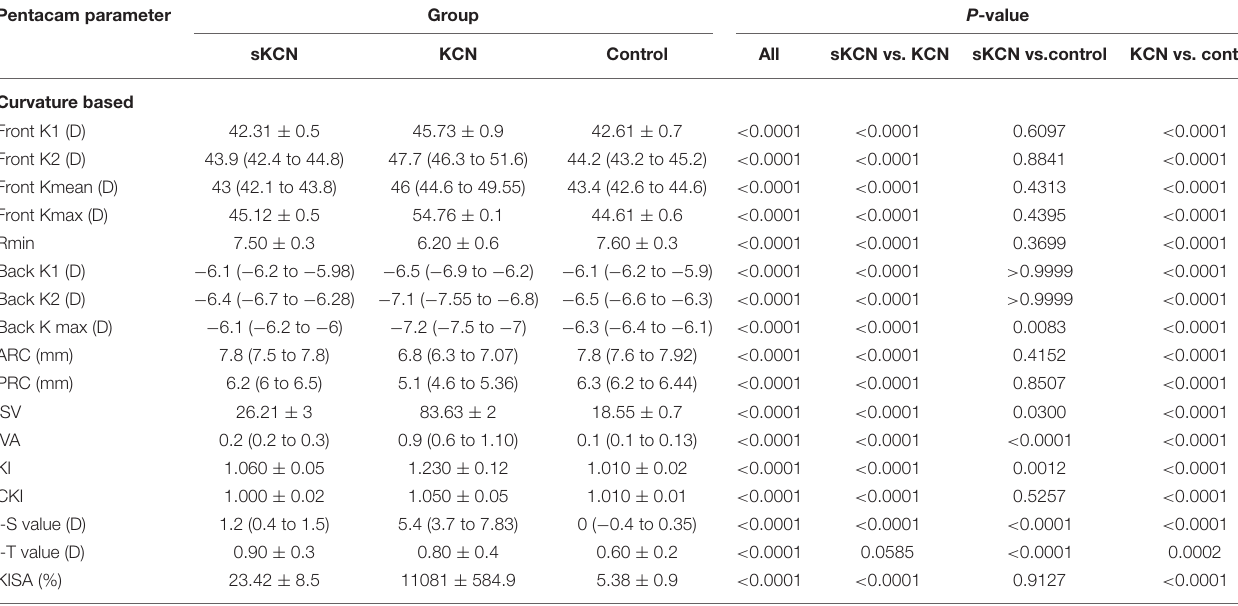
TABLE 3 | Pentacam curvature-based parameters by groups: descriptive statistics and comparisons between groups. Pentacam